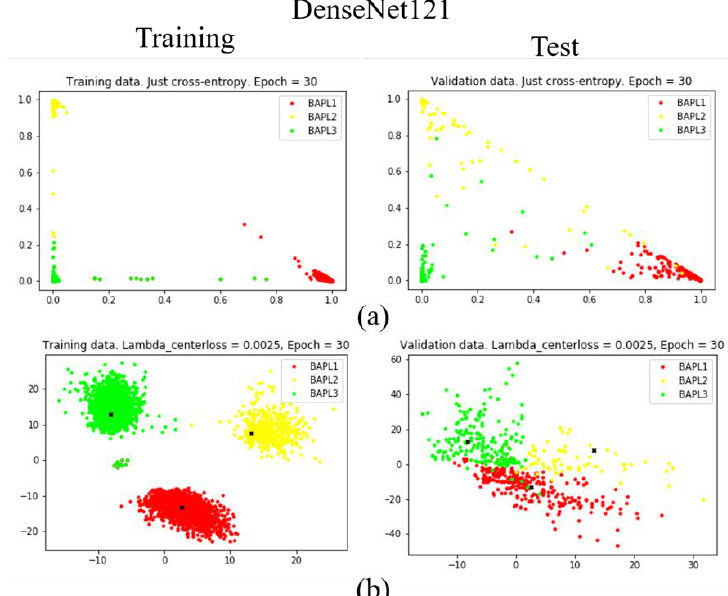
Figure 9. Distributions of training samples, represented by the reduced two-dimensional DenseNet121 features: ( a ) conventional loss function; ( b ) proposed joint loss function. Left: training data; right: test data.